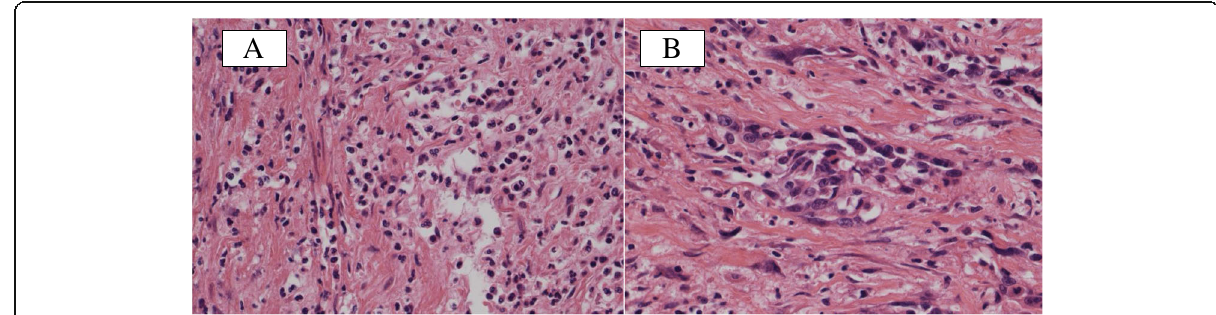
Fig. 4 A histopathological examination revealed extensive inflammation and necrosis around the uretero-arterial fistula ( a hematoxylin eosin staining) and an infiltrative squamous cell carcinoma in the surrounding tissue ( b hematoxylin eosin